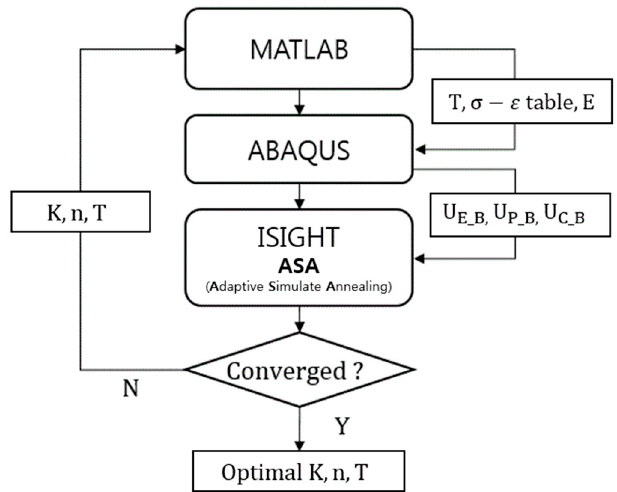
Figure 10. Flowchart of the parameter calibration for the equivalent beam models of SNF.